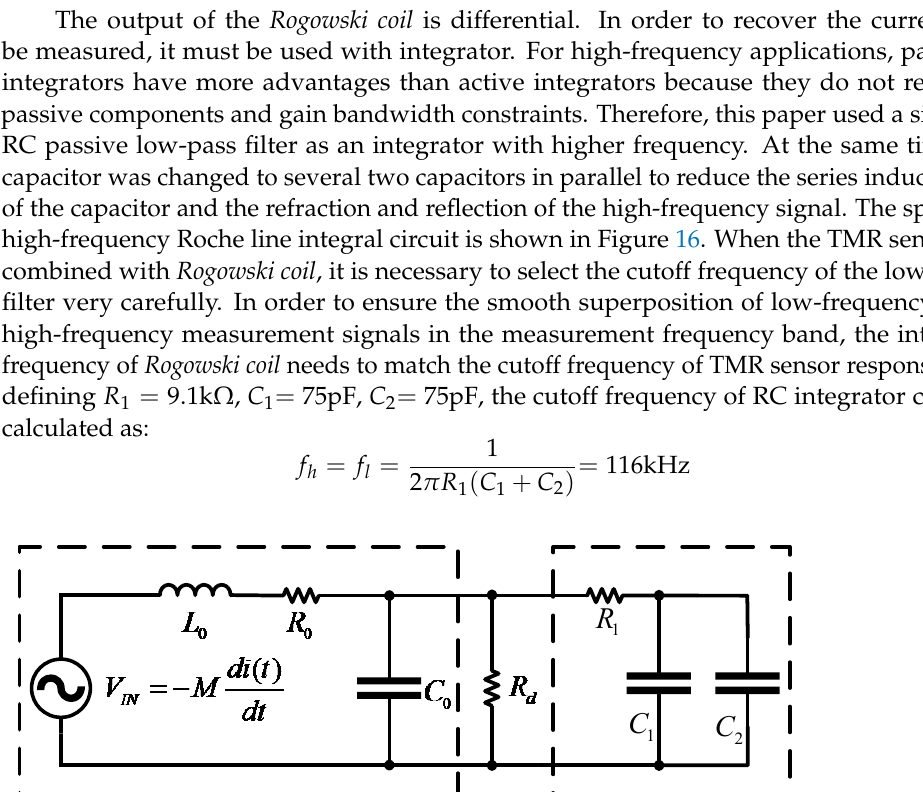
Figure 17. Composite current sensor coupling circuit. In order to achieve the constant sensitivity of the sensor within the working fre- quency range, it is necessary to match the gain multiples of the low-frequency and high- frequency measurement signals to make them equal. Specific to the composite circuit, the ratios of R14/R52, R14/R53, R14/R59, R14/R63, and R14/R56 need to be adjusted. Com- bined with the parameters of the previously designed toroidal array TMR low-frequency current sensor, the openable PCB high-frequency Roche coil current sensor, and the cor- responding back-end processing circuit, the specific settings of the electrical parameters in the composite circuit of the composite wide bandwidth current sensor are shown in Table 3. Table 3. Electrical parameters of composite current sensor coupling circuit. 52 R